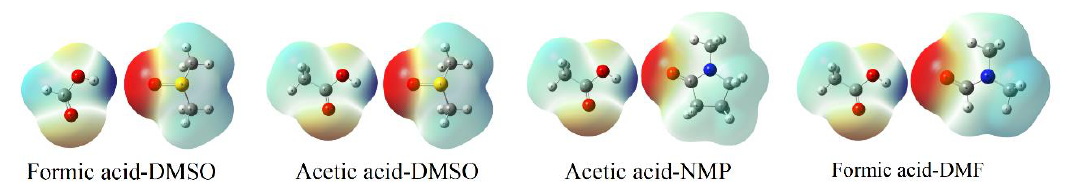
Figure 5. Hydrogen bonding sites of formic acid–DMSO and acetic acid–polar aprotic solvent molecules. The qualitative size of the electrostatic potential corresponds to shaded regions of Table 3. NPA charges of hydrogen bond atoms, hydrogen bond length, and energy.